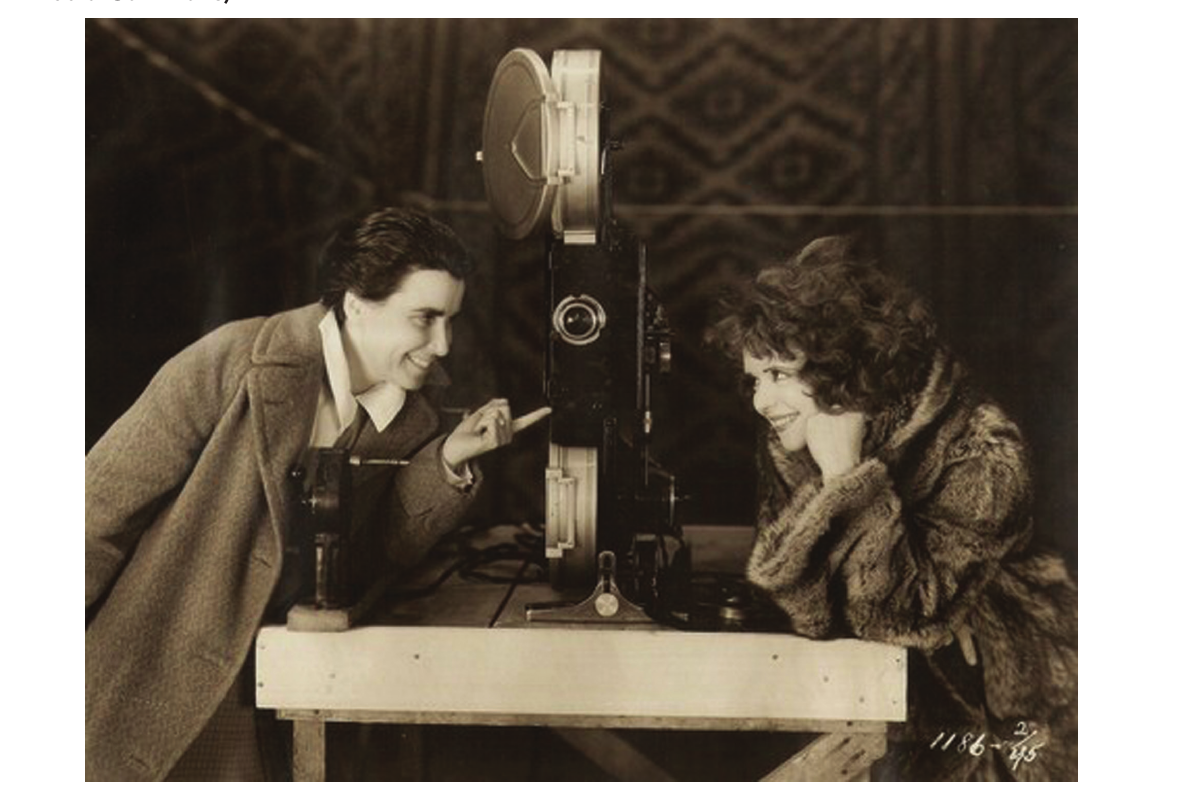
Figure 3. Arzner (left) shares a light moment with Clara Bow on the set of The Wild Party in 1929. With its college setting, The Wild Party was a favourite among Arzner’s UCLA students (Source: Wikimedia